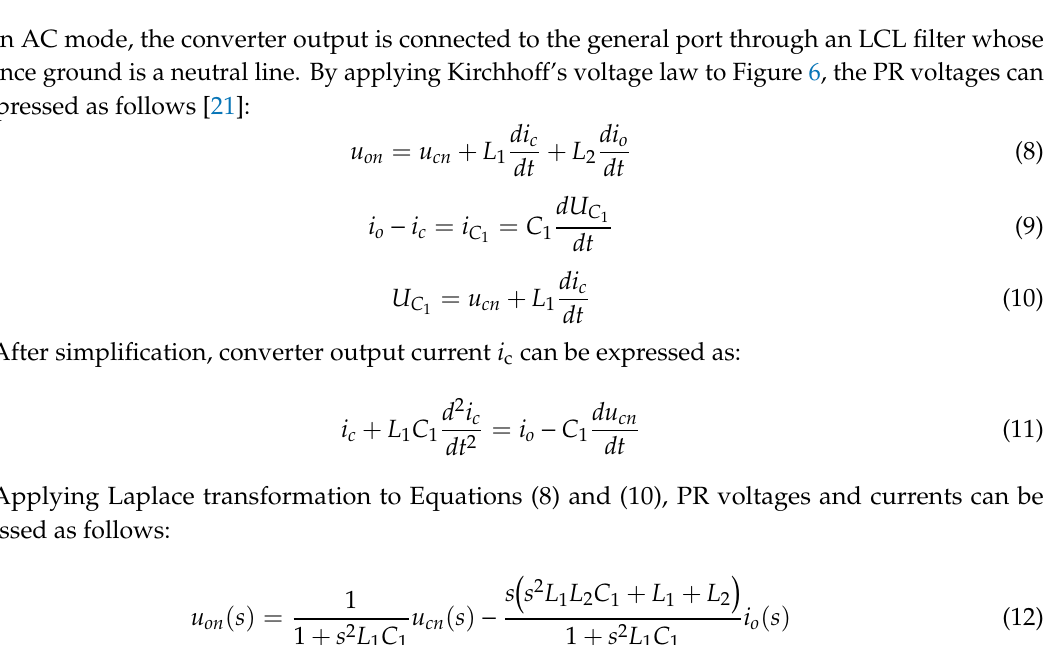
Figure 6. PR filter model in steady state ( a ) AC mode; ( b ) DC